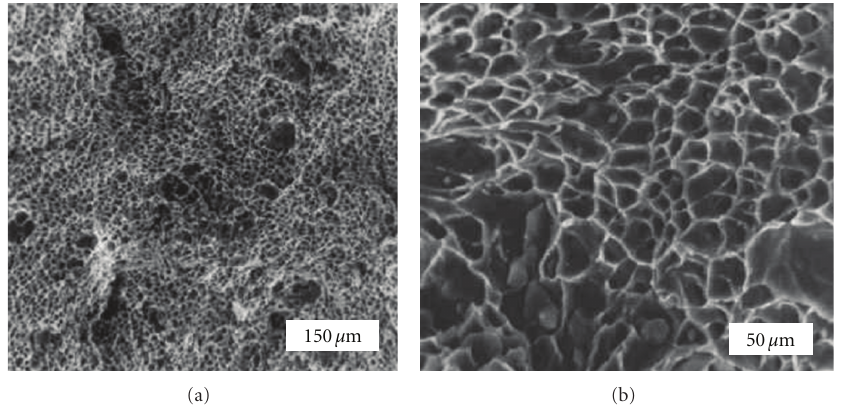
Figure 5: Fractography of the iron grade OSCh 6-2 with 5.9% porosity specimens: (a) × 200; (b) × 750.